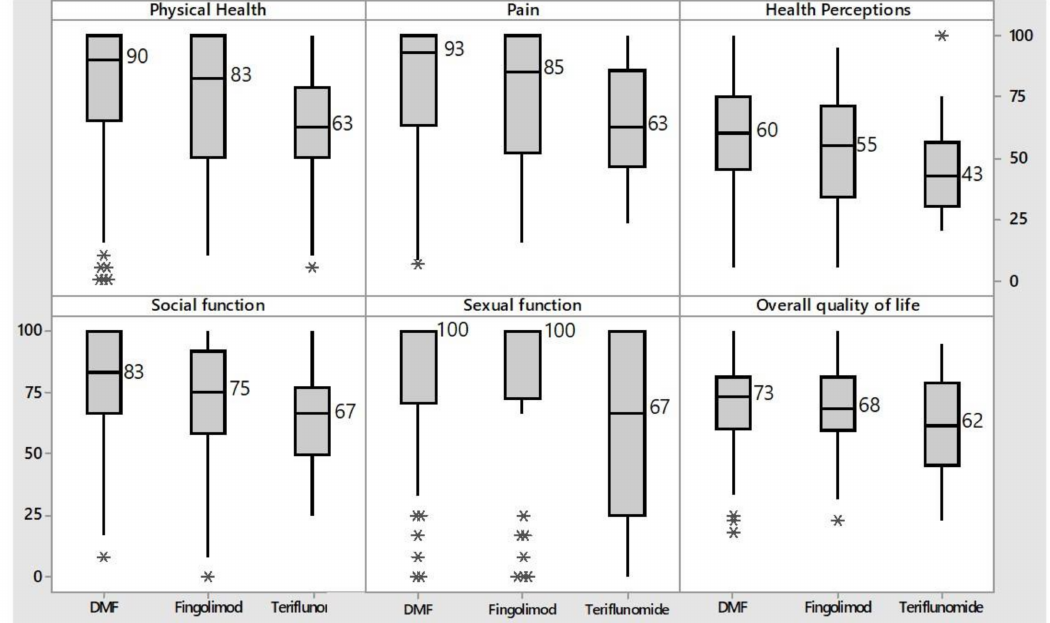
Figure 4. Distribution of the main subscales of MSQoL-54 influenced by oral drugs. DMF = dimethyl fumarate. Data falling outside the 1st and 3rd quartiles’ range are plotted as outliers of the data